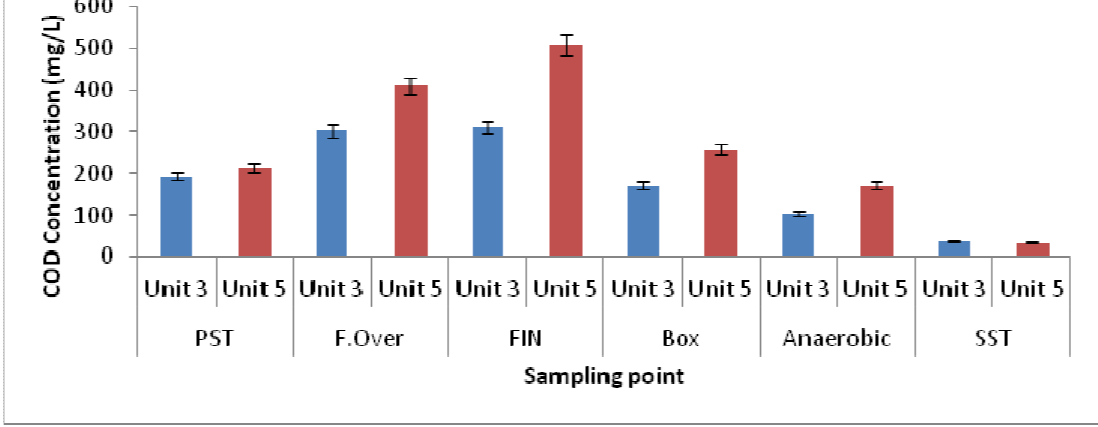
Figure 3. COD variations in wastewater samples collected from different zones of both Unit-3 and Unit-5 of the Northern Wastewater Treatment Works, Johannesburg, South